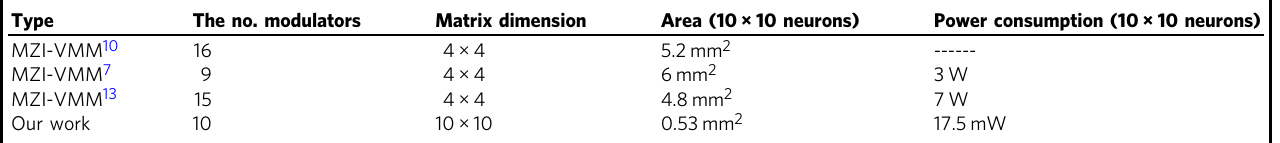
Fig. 5 Handwriting and fashion recognition using the IDNN. a The network consists of a hidden layer W and an output layer W out . The outputs of the output layer are recognition results. The input layer is calculated by the traditional computer and the complex output results of the input layer are converted into amplitude and phase information as the input of the chip. b The numerical testing results of accuracy and loss versus epoch number for the MNIST dataset. c The confusion matrix for our experimental results, using 500 different handwritten digits. d The output intensity distribution of the IDNN for a handwritten input of “ 2 ” is demonstrated. e The numerical testing results of accuracy and loss versus epoch number for the MNIST-Fashion dataset. f The confusion matrix in the experiment. g As an example, the output intensity distribution of the IDNN for a fashion product input of “ pullover ” is demonstrated. Table 1 The performance of our proposed IDNN framework. Type The no. modulators